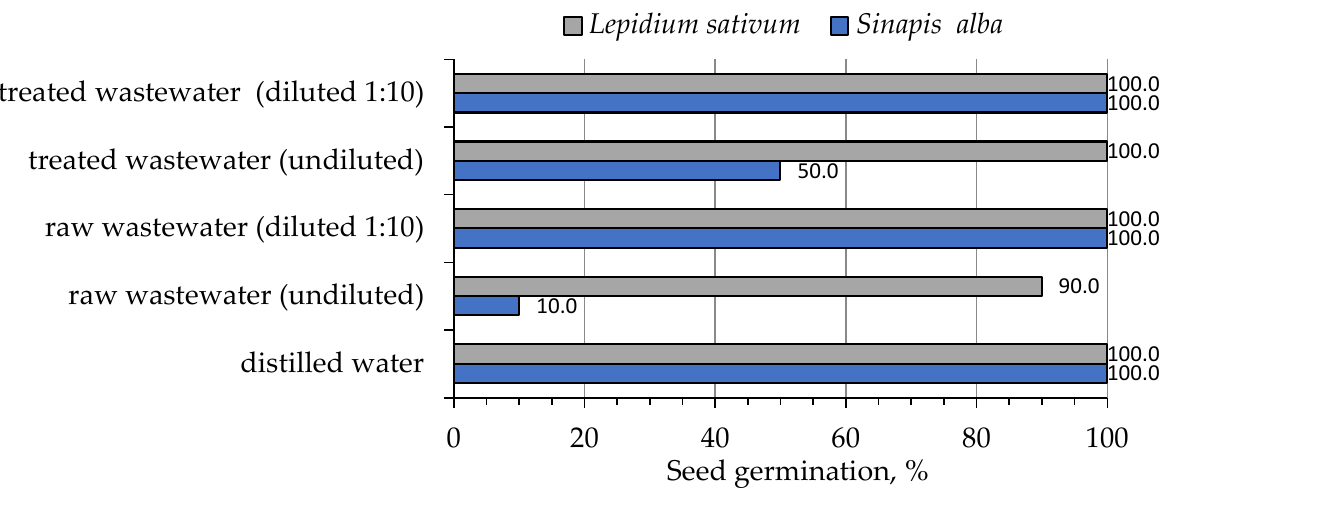
Figure 7. Seed germination of S. alba and L. sativum L. for undiluted and diluted (1:10) wastewater samples.